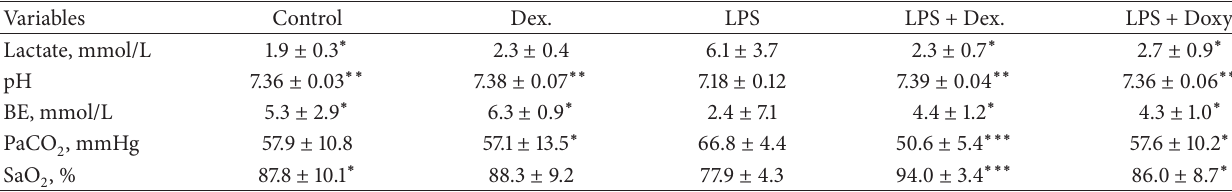
Table 1: Comparison of blood gas analysis (mean ± SD).